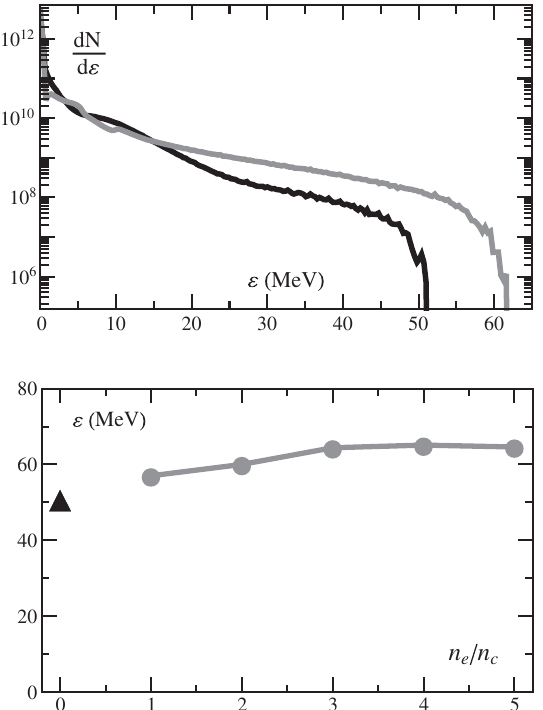
FIG. 7. Comparison of the spectra (upper panel) and maximum ion energies (bottom panel) for the solid density foil and two- layer target. The grey curve and dots correspond to the solid- density foil with low-density coating and the black curve and the triangle correspond to pure overdense